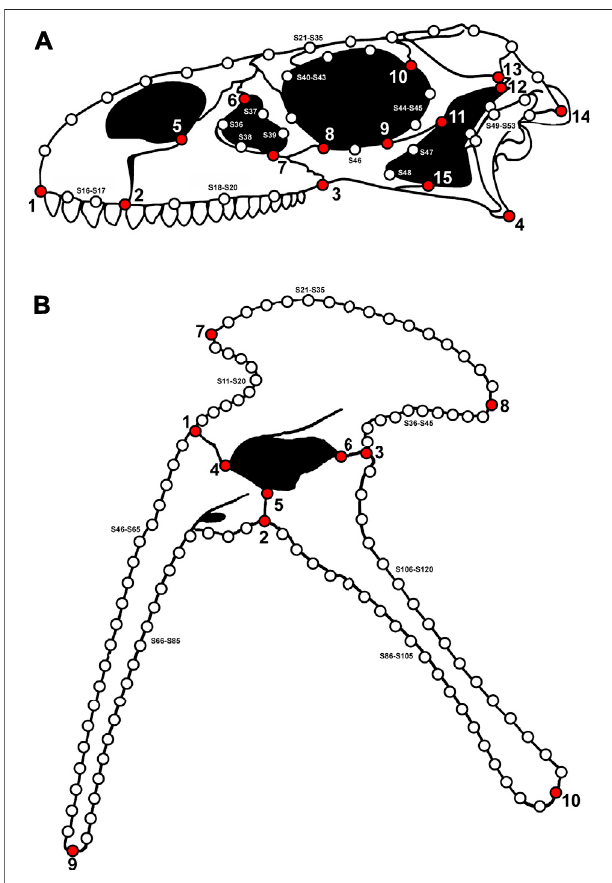
FIGURE 1 | Images showing the landmark scheme used to assess 2D cranial and pelvic shape. (A) 15 landmarks and 38 semilandmarks plotted on the cranium of Adeopapposaurus in lateral view (modi fi ed from Martínez, 2009). (B) 10 landmarks and 110 semilandmarks plotted on the pelvic girdle of Eoraptor in lateral view (modi fi ed from Sereno et al., 2013). Landmarks are indicated by large red points and semilandmarks by small white points. A full description of landmark positions is given in the Supplementary File S1-Tables S2, S3 .